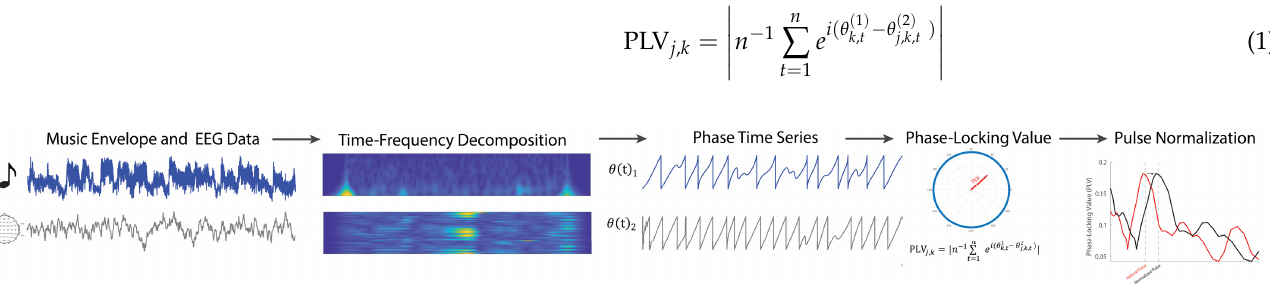
Figure 1. Measuring neural entrainment to musical pulse. Neural entrainment to musical pulse and rhythm was quantified as the phase-locking value (PLV) between EEG channel activity and the envelope of each musical recording. First, raw EEG channel activity was preprocessed, and the amplitude envelope of each musical recording was estimated. A time-frequency decomposition, using the complex wavelet transform, was then conducted to estimate instantaneous phase information in the EEG time-series and musical envelopes. PLVs were computed from the resulting phase time-series. Finally, PLVs underwent pulse normalization, prior to second-level